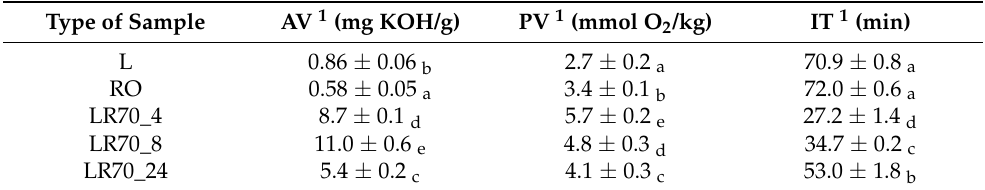
Table 3. Acid value, peroxide value, and oxidation induction time of raw materials and mixtures after